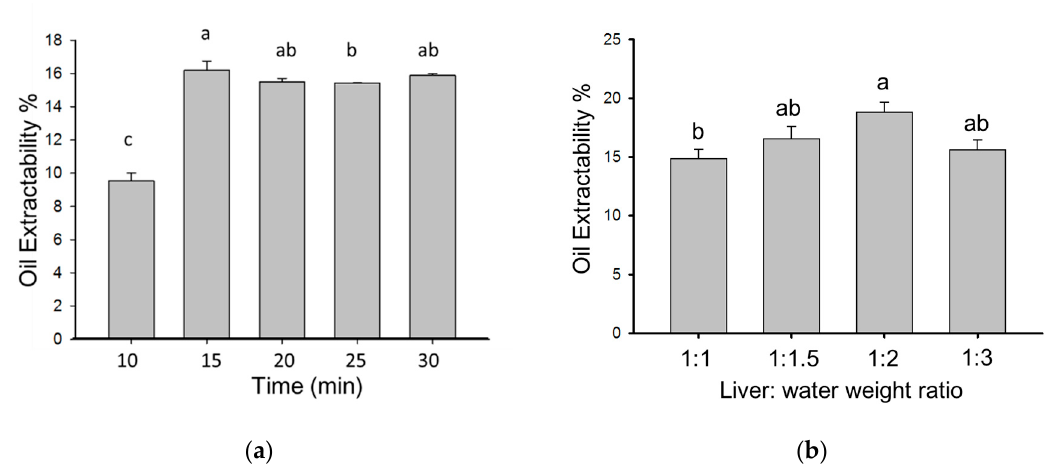
Figure 1. Effects of ( a ) cooking time and ( b ) substrate water ratio on the oil extractability by using AE. The different letters in the graphs indicate a significant difference at p < 0.05.